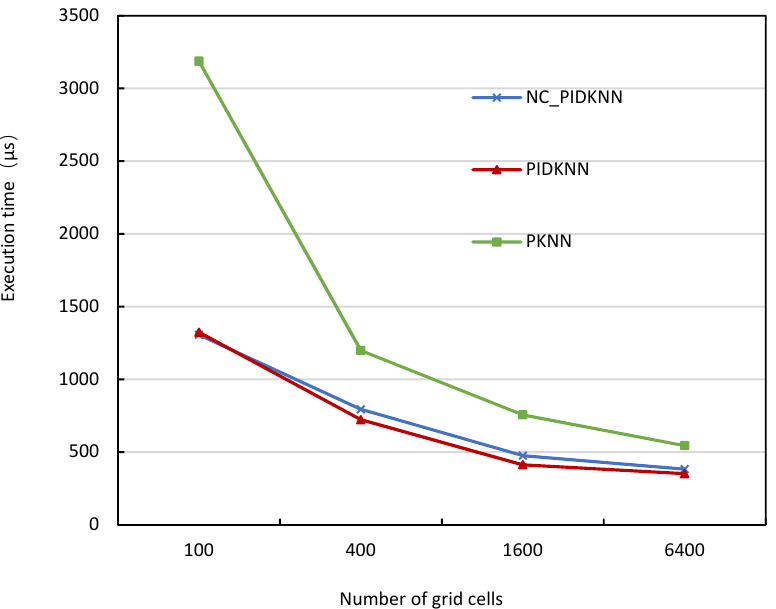
Figure 6. Variation of execution time with the number of grid cells for the three algorithms